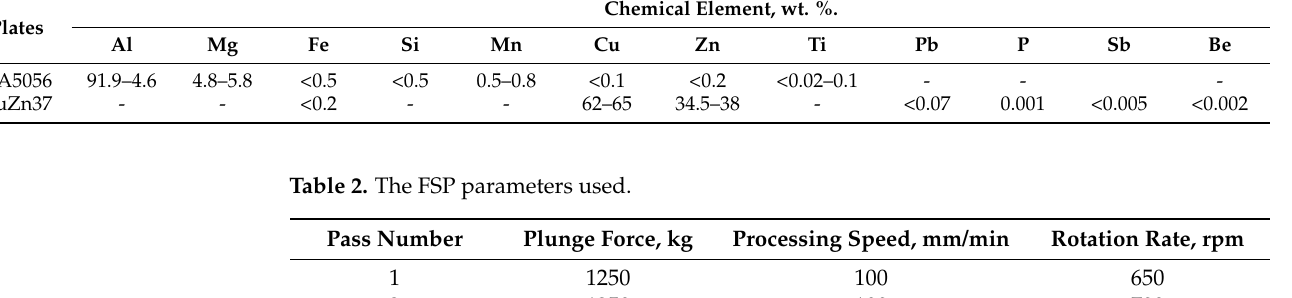
Figure 1. Schematic diagram of FSP on dissimilar metals and sampling. Table 1. Chemical composition of A5056 and CuZn37 brass plates. Chemical Element, wt. %.